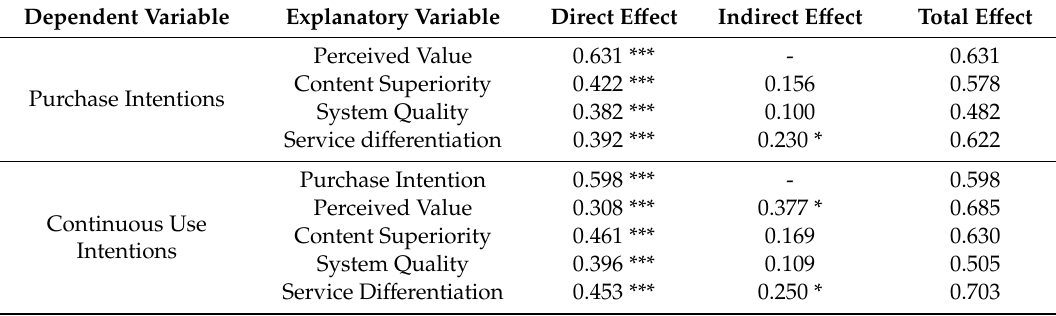
Table 6. Direct, indirect and total e ff